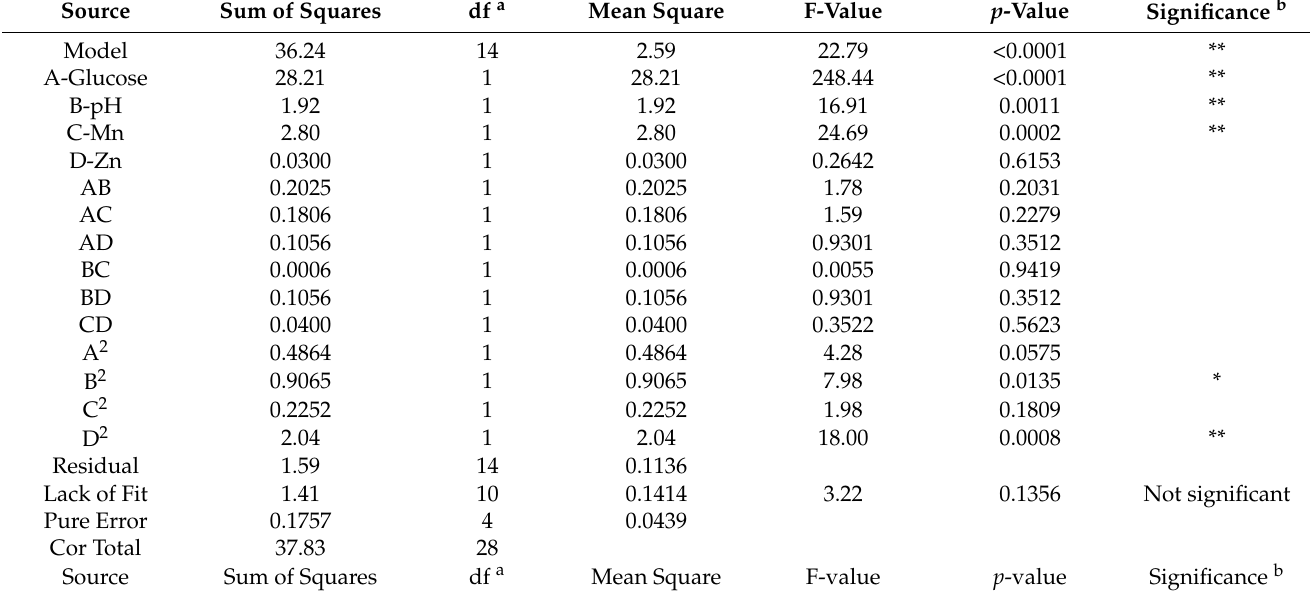
Table 3. The ANOVA details of the fitted equation model for the production of